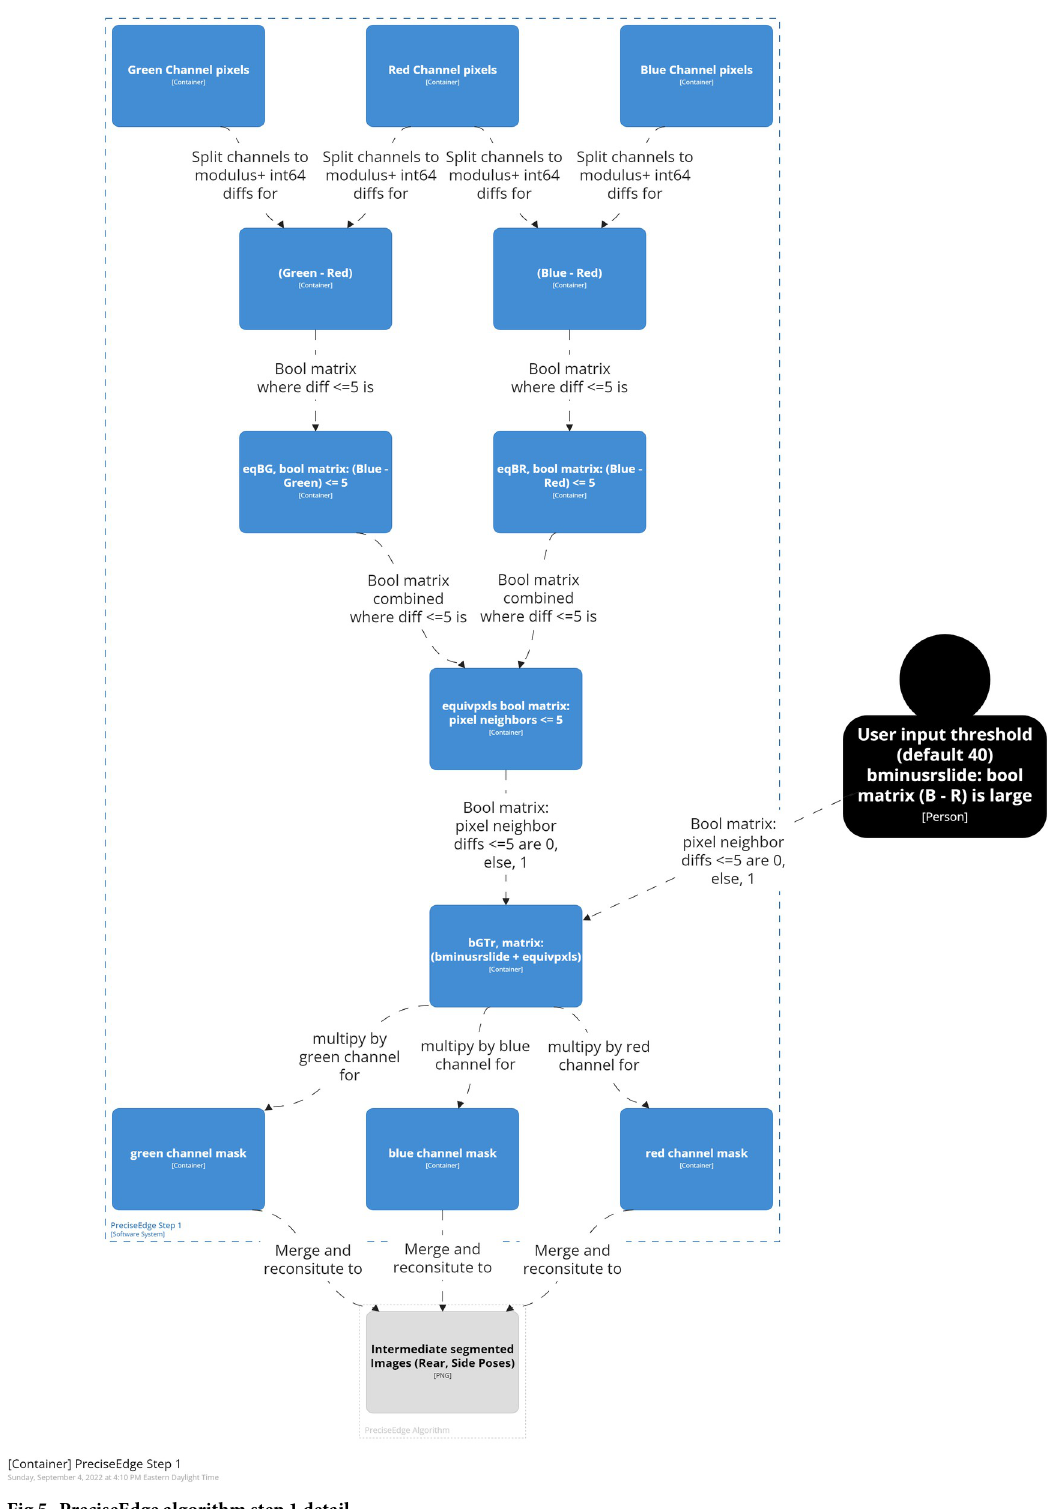
Fig 5. PreciseEdge algorithm step 1